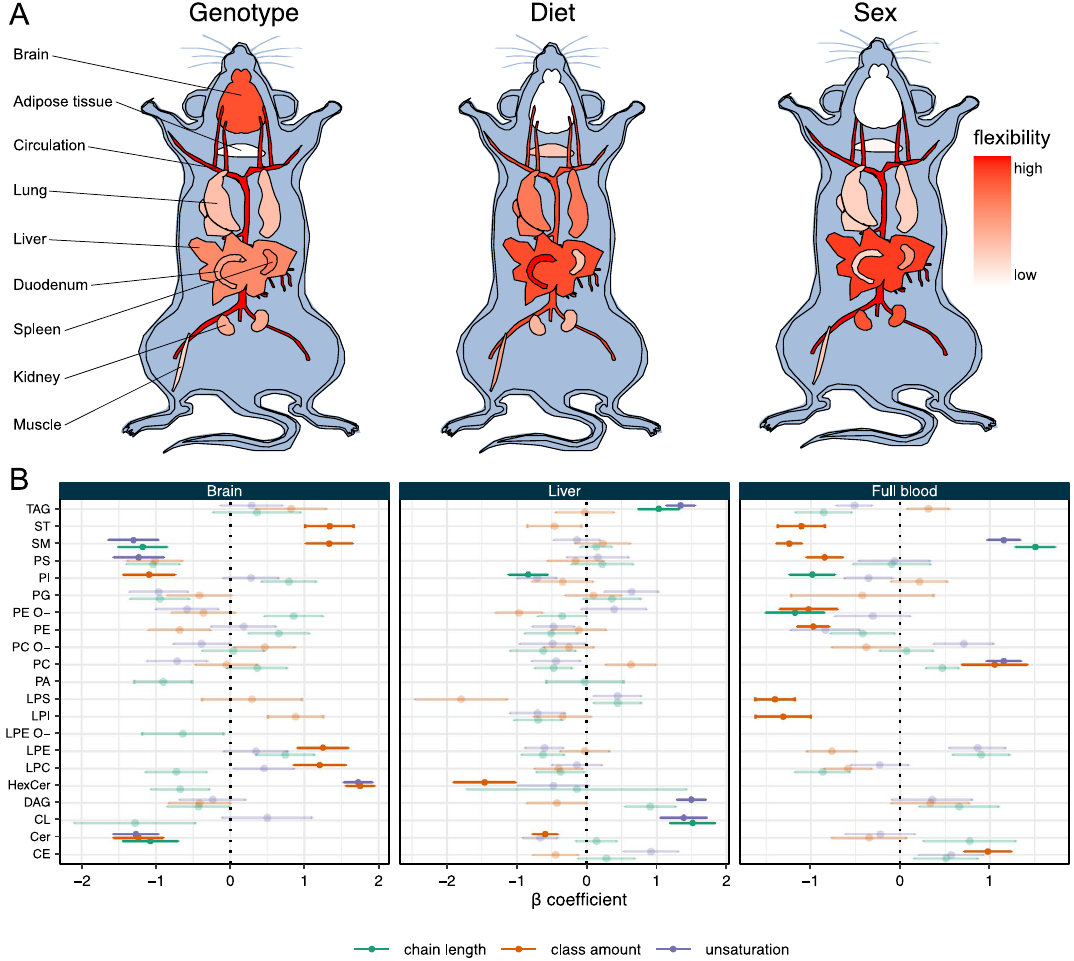
Figure 4. Flexibility of the mouse lipidome. ( A ) Analysis of lipidomic flexibility in mouse organs based on the tested experimental conditions. For details see main text. Mouse plots were created with the R library gganatogram (v.2) 34 . ( B ) Analysis of lipidomic responses by multiple linear regression. Shown are β coefficients. Error bars indicate standard error. Examples shown are: Genotype effects for brain; diet effects for liver; sex effects for full blood. Significantly affected features ( p < 0.01 ) are displayed